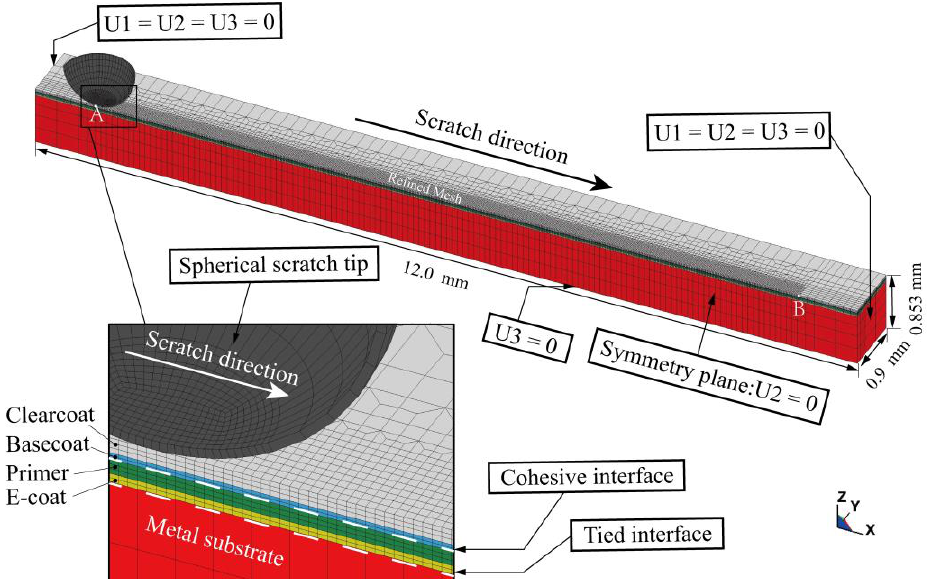
Figure 2. Scratch FE model of the automotive coating system, which could consider the interlaminar interface failure by the employment of the LDCZM.